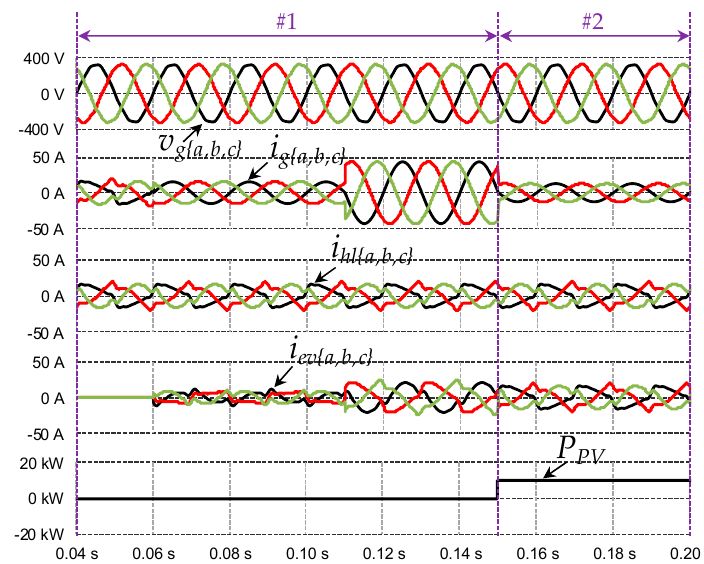
Figure 18. Principle of operation representative of the off-board EVBC: Unified operation as a power quality compensator with renewables.